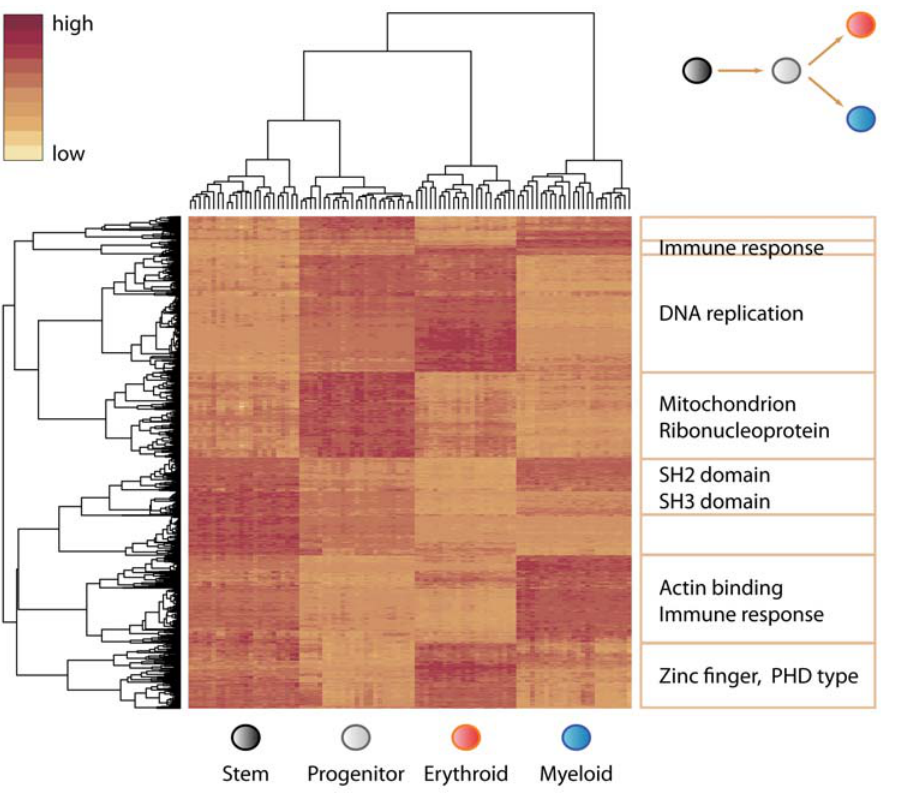
Figure 1. Mean expression levels for all probes in the four cell types. Unsupervised clustering including all probes for the 96 RNA samples follows cell type (top hierarchical tree), while clustering of the 876 most varying probes reveals distinct categories of genes that show cell-type– specific expression (left hierarchical tree). The heat map shows the expression patterns of those probes and selected enriched gene categories in each major cluster. Discriminatory genes are enriched in various functional classes, including SH2/SH3 domain containing transcription factors for stem cells, mitochondrial genes for progenitor cells, genes involved in DNA replication and zinc fingers for erythroid cells, and immunoglobulin type genes for myeloid cells (all p -values , 0.05). For genes that belong to each of these clusters, see Table S1.